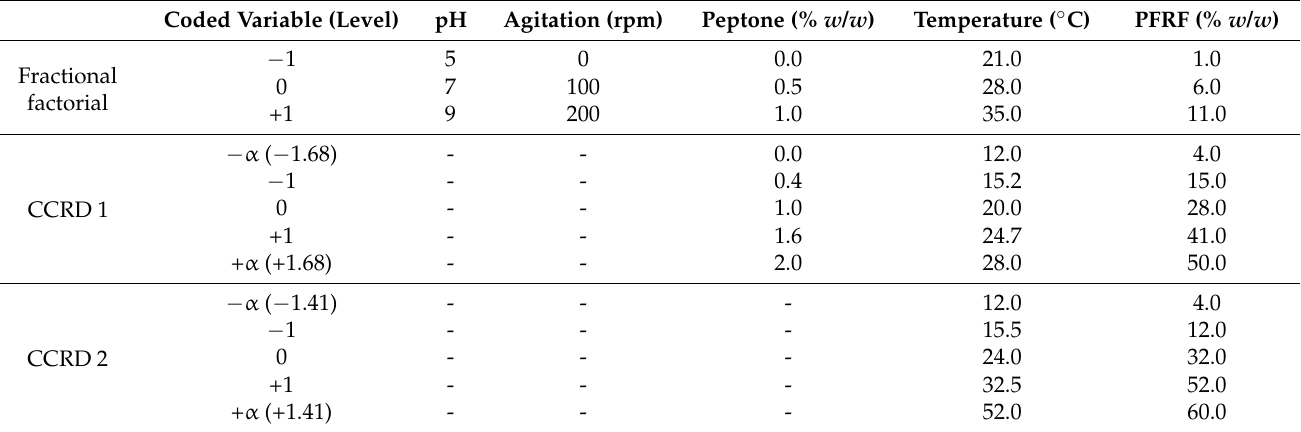
Table 1. Independent variables and coded and noncoded values used in the sequential strategy of experimental designs aiming an increased secretion of